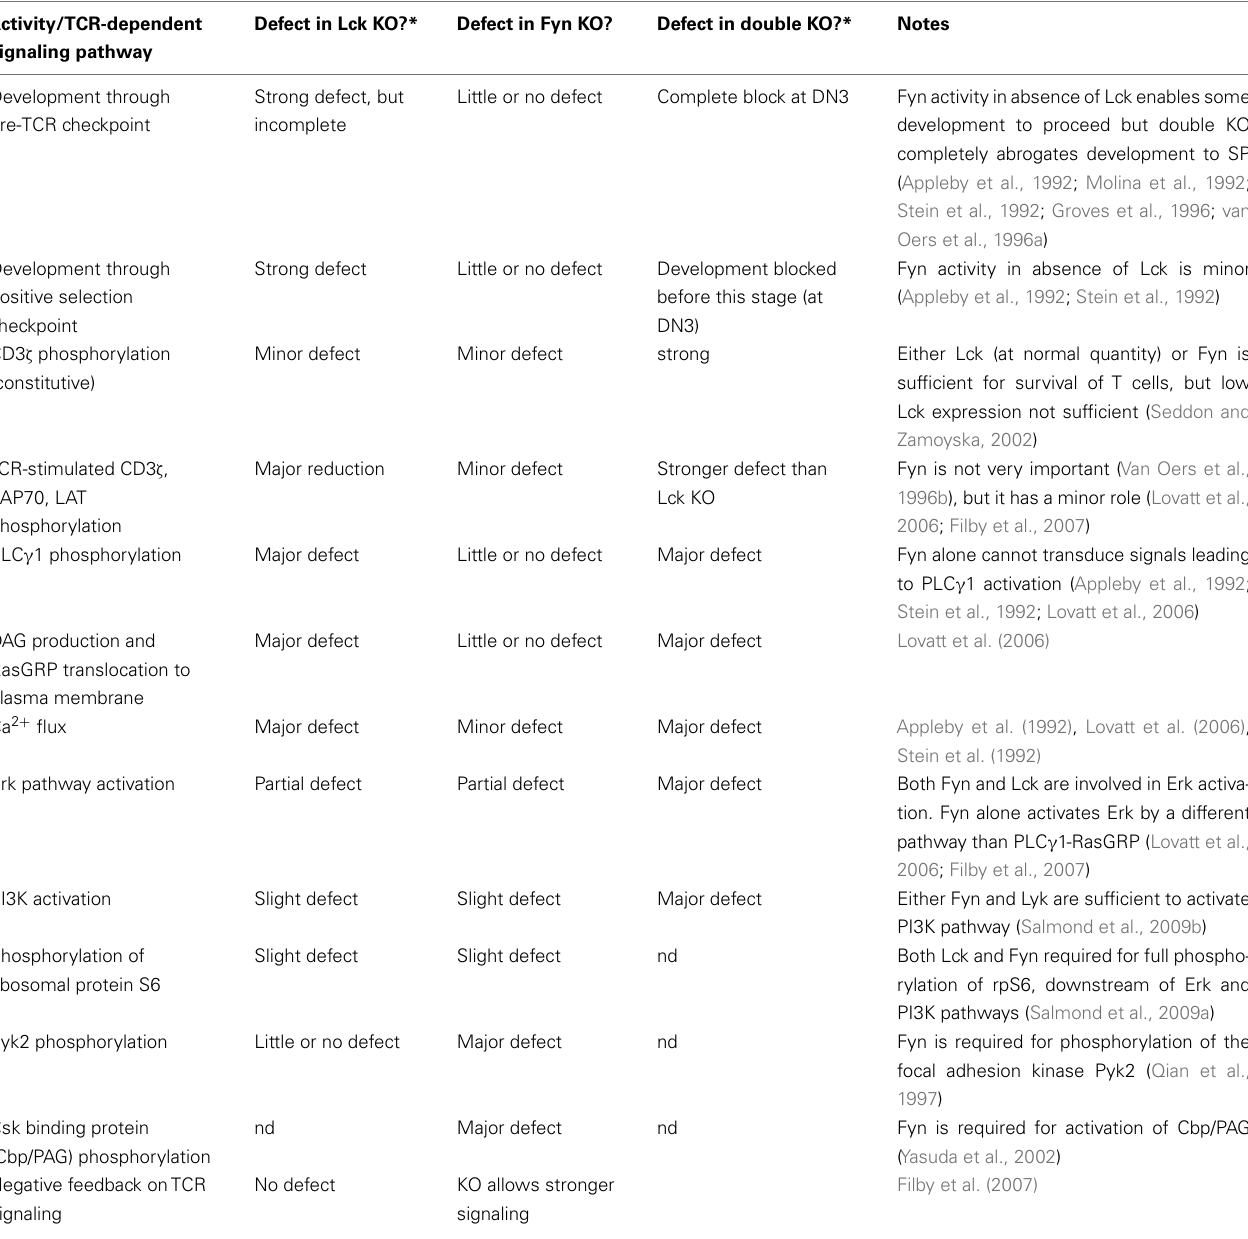
Table 1 | Defects inTCR signaling and development in the absence of Lck and/or